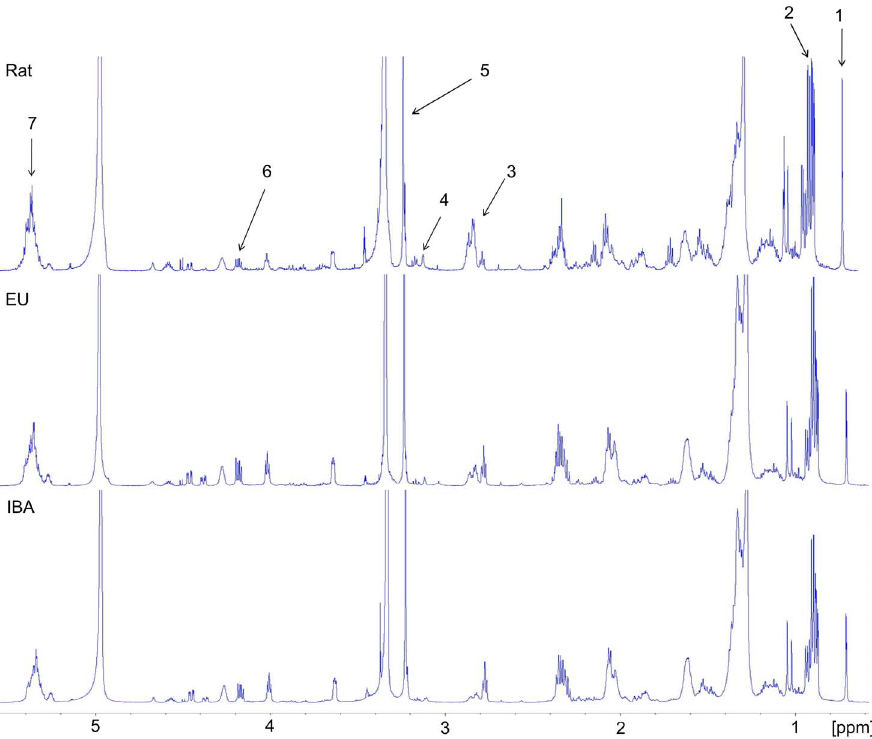
Figure 4. Representative 1 H – NMR spectra of plasma lipid extract samples. Spectra from naı¨ve rats, summer euthermic (EU) arctic ground squirrel, and winter interbout arousal (IBA) arctic ground squirrels. NMR peak assignments: 1, cholesterol; 2, total triglycerides; 3, PUFA, polyunsaturated fatty acids; 4, phosphotidyl ethanolamine; 5, cholines; 6, TAG, triacylglycerol; 7, UFA, unsaturated fatty acids.